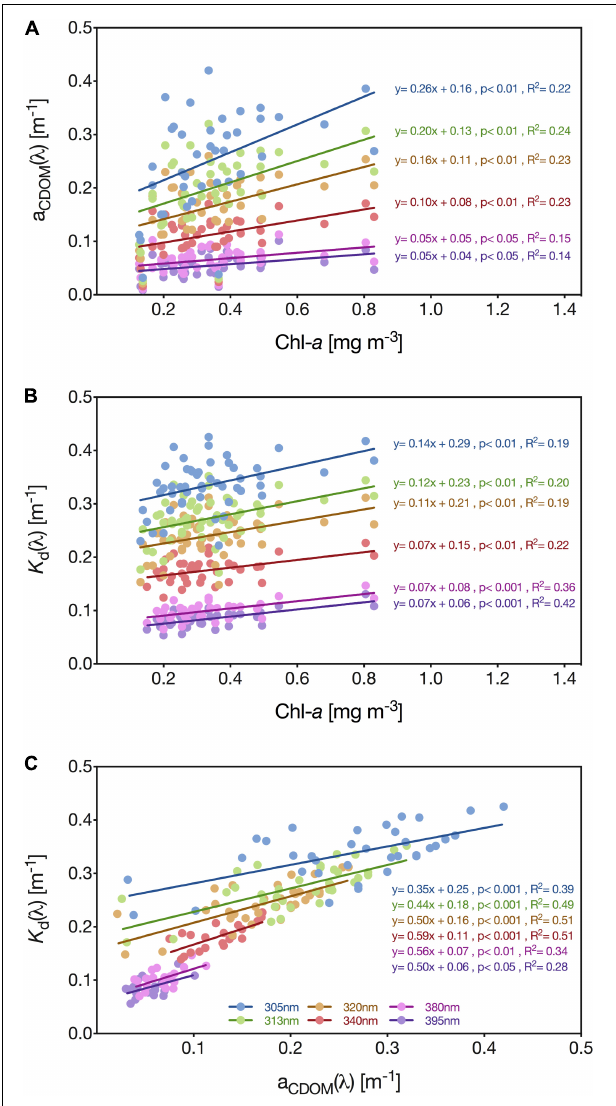
FIGURE 6 | Linear regression analysis of the relationship between a CDOM ( λ ) and the concentration of Chl- a (A) , the downwelling diffuse attenuation coefficient [ K d ( λ )] and Chl- a concentration (B) , and a CDOM ( λ ), and K d ( λ ) and a CDOM ( λ ) (C) for the wavelengths 305 (blue circles), 313 (green circles), 320 (brown circles), 340 (red circles), 380 (pink circles), and 395 nm (purple circles). Solid lines represent linear regression